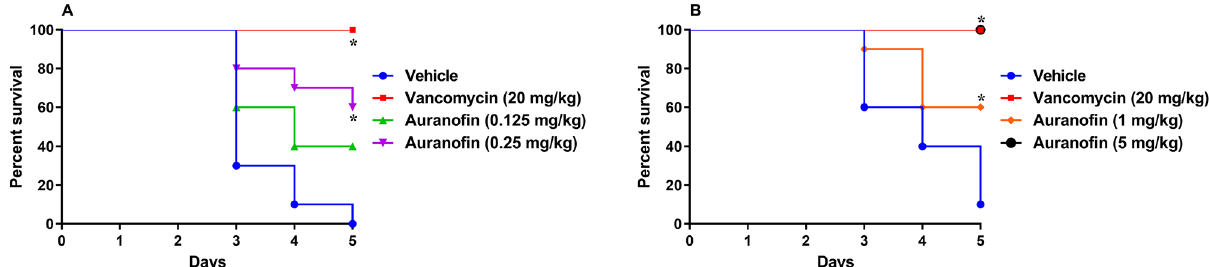
Figure 1. Efficacy of auranofin in treatment of CDI in hamsters: ( A ) low doses of auranofin (0.125 mg/kg and 0.25 mg/kg) and ( B ) high doses of auranofin (1 mg/kg and 5 mg/kg). Hamsters were treated with auranofin, vancomycin (20 mg/kg), or the vehicle for 5 days after infection with C. difficile UNT103-1. Kaplan–Meier survival curves were analyzed using a log-rank (Mantel–Cox) and Gehan–Breslow–Wilcoxon tests (P < 0.05). An asterisk (*) denotes a statistically significant difference between hamsters treated with either auranofin or vancomycin in comparison with the vehicle-treated